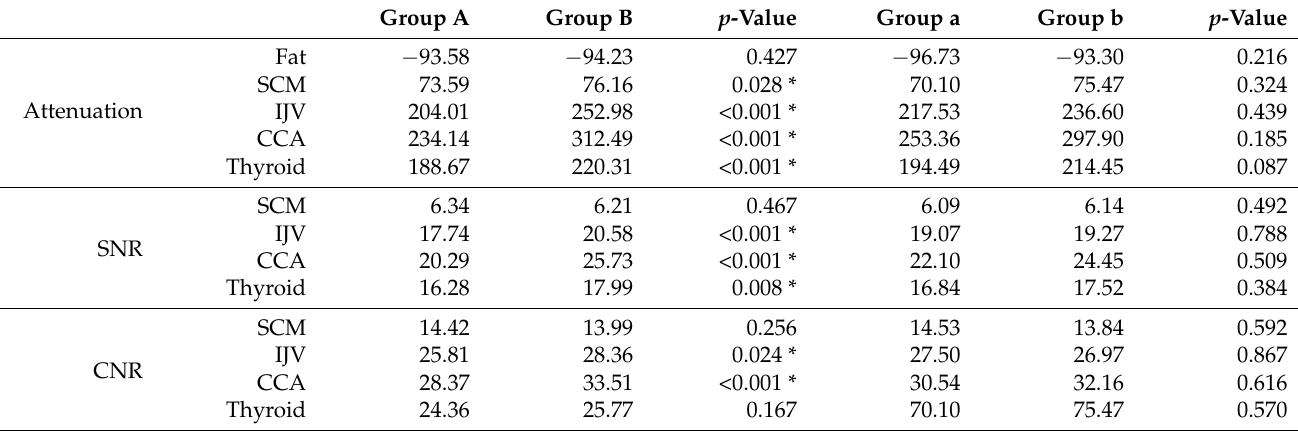
Table 5. The mean attenuation, SNR, and CNR of quantitative analysis.